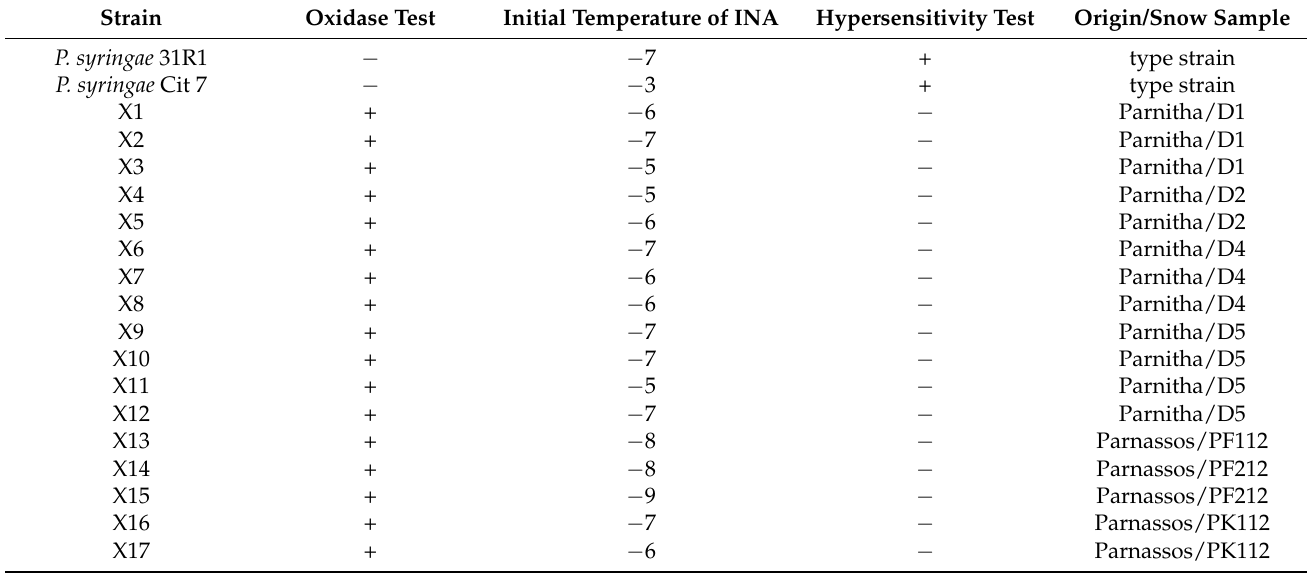
Table 2. Ice nucleation and basic microbiological properties of strains isolated from snow samples. Pseudomonas syringae strains 31R1 and Cit7 were included in the experiment as type